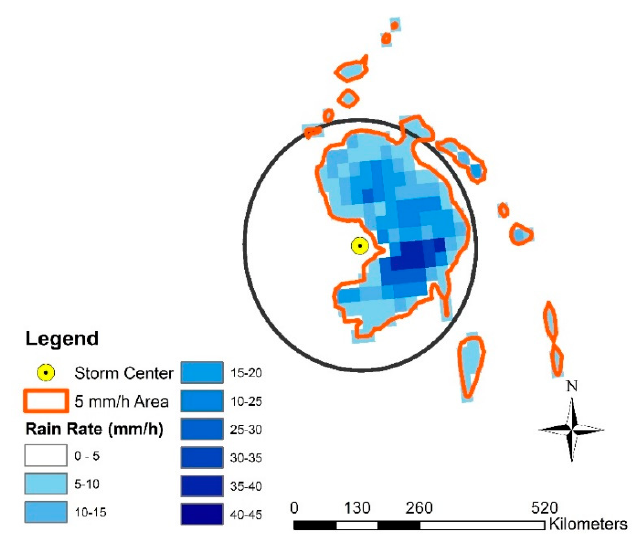
Figure 2. Regions where rain rates exceed 5 mm hr − 1 (orange line) and that intersected with or were within 250 km of the storm center (black line) were selected for analysis. Example from Hurricane Ivan (2004).